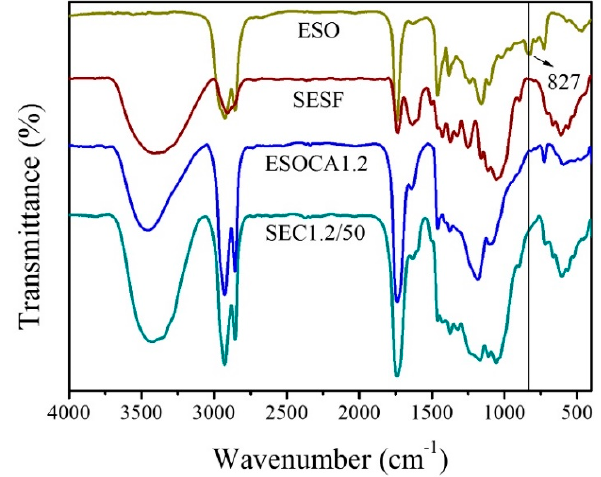
Figure 2. Fourier-transfer infrared spectroscopy (FT-IR) spectra of epoxidized soybean oil (ESO), steam exploded sisal fiber (SESF), CA-cured ESO Resin with R =1.2 (ESOCA1.2), and SESF/ESOCA1.2/50 biocomposites (SEC1.2/50).